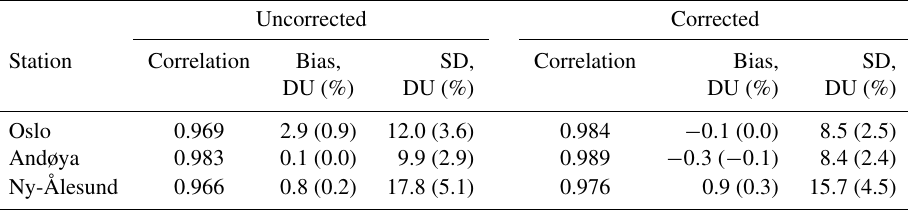
Table 4. Correlation, bias, and SD in total ozone from GUV and Brewer (and SAOZ) instruments. The left columns are for uncorrected GUV data, whereas the right columns are for SZA- and CLT-corrected GUV total ozone data. Bias and SD are both expressed in DU and percent (in parenthesis).